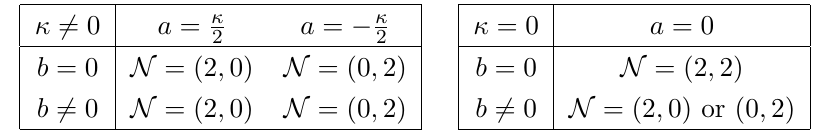
= + b j e j (cid:10) or i i 23